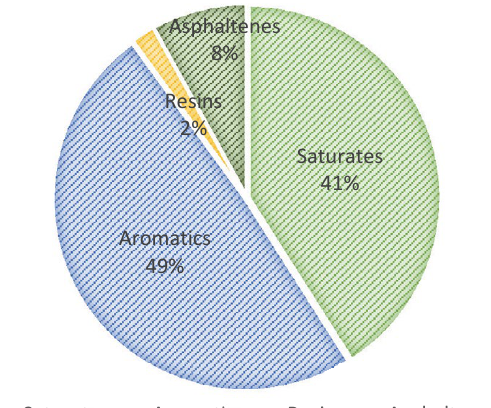
Fig. 1: SARA analysis of the crude oil.